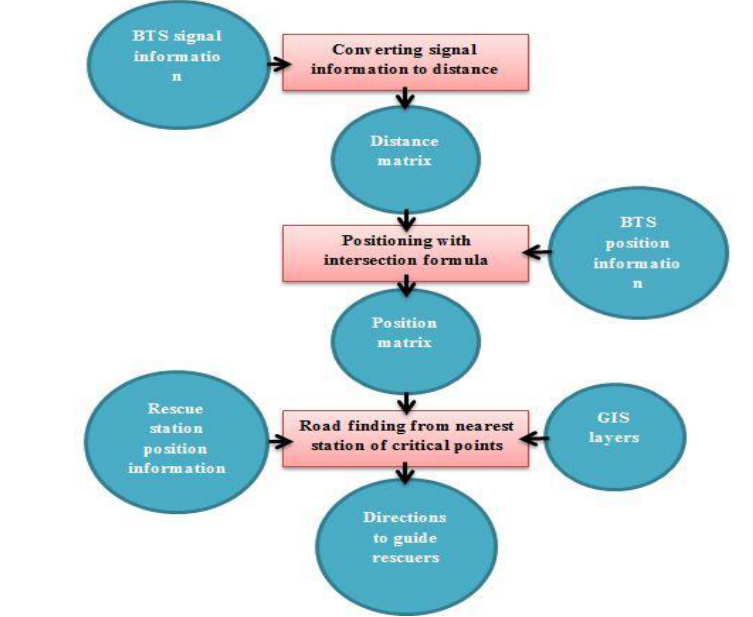
Figure 7. Flowchart of programing